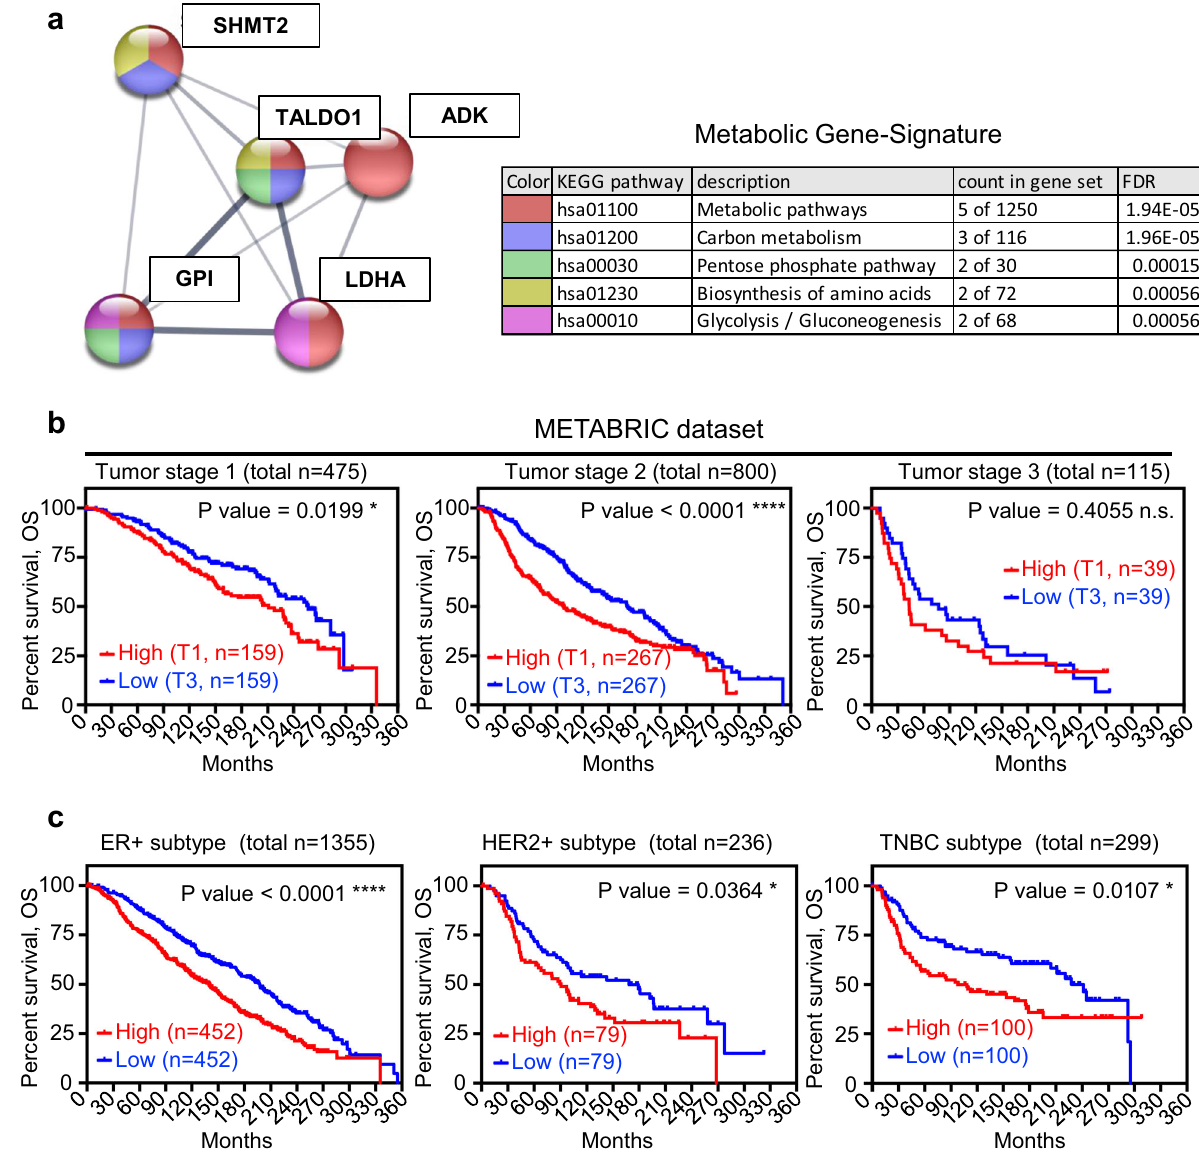
Fig. 5 Five-gene metabolic signature predicts poor outcome in early stages of breast cancer independent of breast cancer subtypes. a Functional network analysis and functional enrichment analysis of fi ve metabolic proteins. Functional network analysis is performed by String (https://string-db.org/) 71 . b Survival curves of breast cancer patients with tumor stage 1 – 3 samples that are categorized into two subgroups as upper tertile (T1) and lower tertile (T3) based on the mean mRNA z -score of 5 metabolic genes per sample from the METABRIC dataset. c Survival curves of patient subgrouping based on 5-gene metabolic signature with different subtypes of breast cancer including ER + , HER2 + , and TNBC from METABRIC dataset. P value of survival analysis was calculated based on Log-Rank Test in Prism software. * P < 0.05, **** P < 0.0001 and ns not signi fi